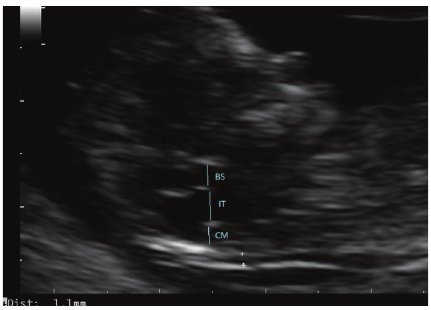
Figure 1: Fetal ultrasound image (sagittal view) at 11 + 4 weeks of gestation, showing an enlarged intracranial translucency (IT) in the posterior fossa, the brain stem (BS), and the cisterna magna (CM).